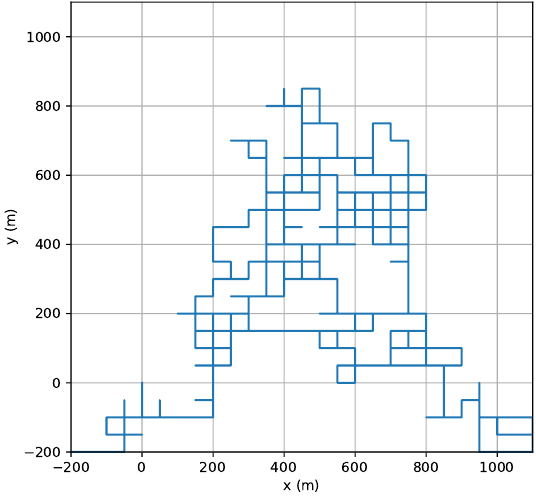
Figure 2. An example of a node’s movement using the RW mobility